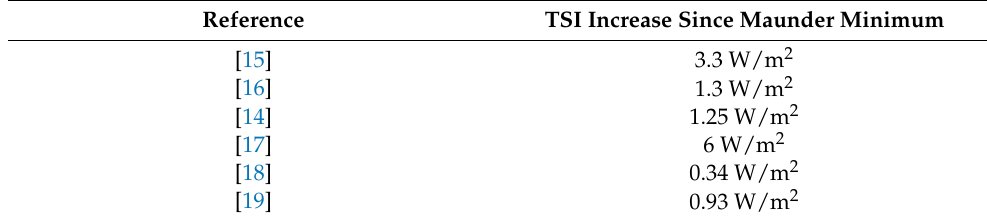
Table 1. List of various studies on the TSI increase since the Maunder Minimum.